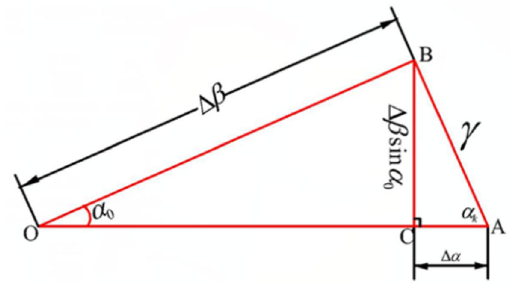
Fig. 6 Diagram for calculating